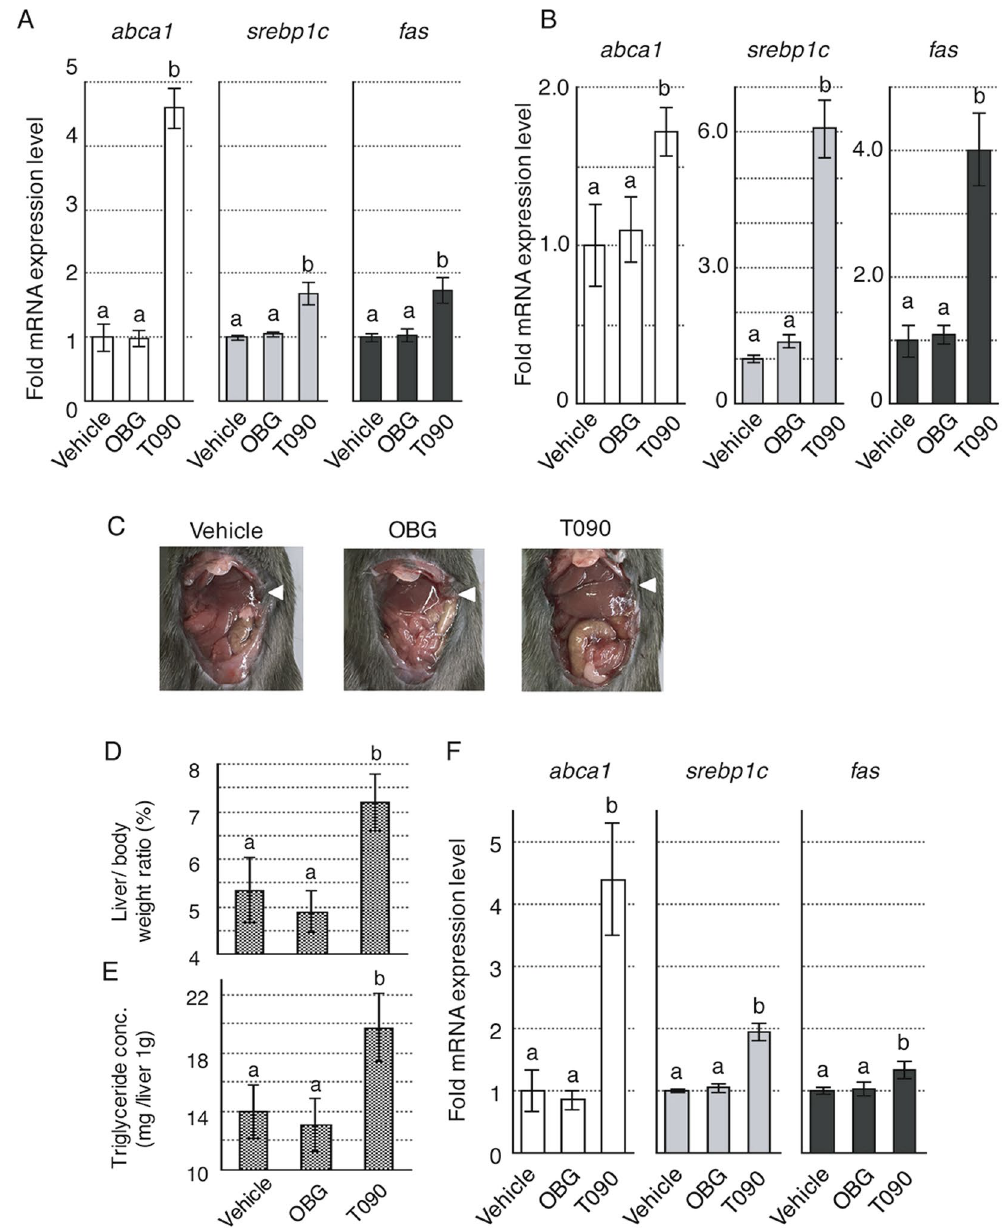
Figure 2. OBG did not cause hepatic steatosis. ( A , B ) OBG does not up-regulate the mRNA levels of lipogenesis- related genes in the liver. The mRNA levels of abca1 , srebp1c and fas in Hepa1–6 cells ( A ) or HepG2 cells ( B ) were measured at 48 h after treatment with 10 − 6 M OBG or 10 − 6 M T0901317 by qRT-PCR and normalised against gapdh . The fold change in vehicle versus ligand-treated cells is shown. Means ± SD are calculated from triplicate measurements in three independent experiments. Values followed by different letters are statistically different based on ANOVA followed by SNK tests (P < 0.01). ( C – E ) OBG treatment does not cause the undesirable symptoms of hypertrophic liver. Representative photographs of mouse liver samples after 10 mg/kg OBG or T0901317 treatment are shown. Each liver was indicated by arrow ( C ). Ratio of liver to body weight ( D ) and the triglyceride concentration in the liver ( E ) are depicted. Means ± SD were calculated from biological replicates (vehicle, n = 5; OBG, n = 4; T0901317, n = 4). Values followed by different letters are statistically different based on ANOVA followed by SNK tests (P < 0.01). ( F ) Effect of OBG on lipogenesis-related gene expression in M-1 cells. Levels of abca1 , srebp1c and fas mRNA were determined as described in Fig.